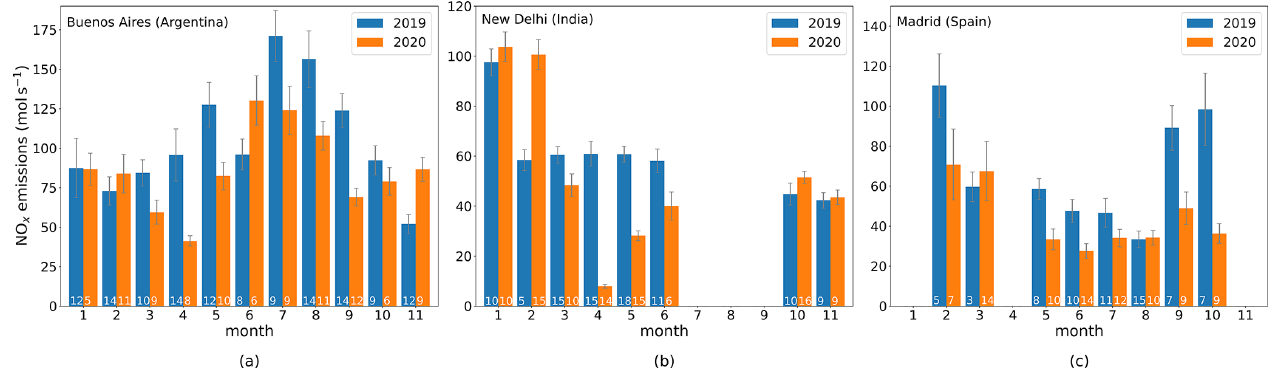
Figure 8. Monthly NO x emissions calculated with the EMG method using TROPOMI NO 2 tropospheric column data for 2019 (blue) and 2020 (orange) from January to November for (a) Buenos Aires (Argentina), (b) New Delhi (India), and (c) Madrid (Spain). The numbers in the bars represent the number of available days for the monthly mean. Due to an insufficient data availability of less than 3d, comparisons are not possible for some months. Error bars are the standard deviation derived by the EMG fitting procedure for emission